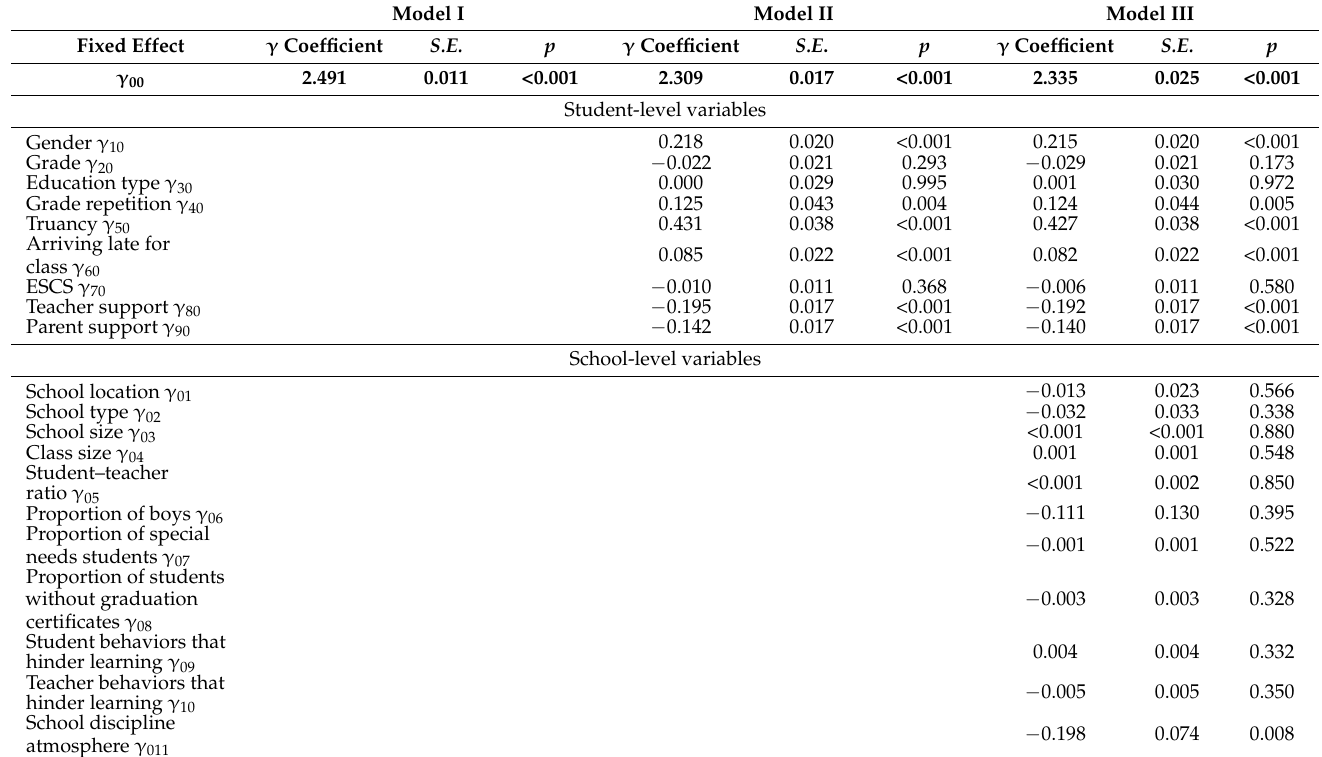
Table A1. Multilevel analysis results of the influencing factors of students suffering from rational